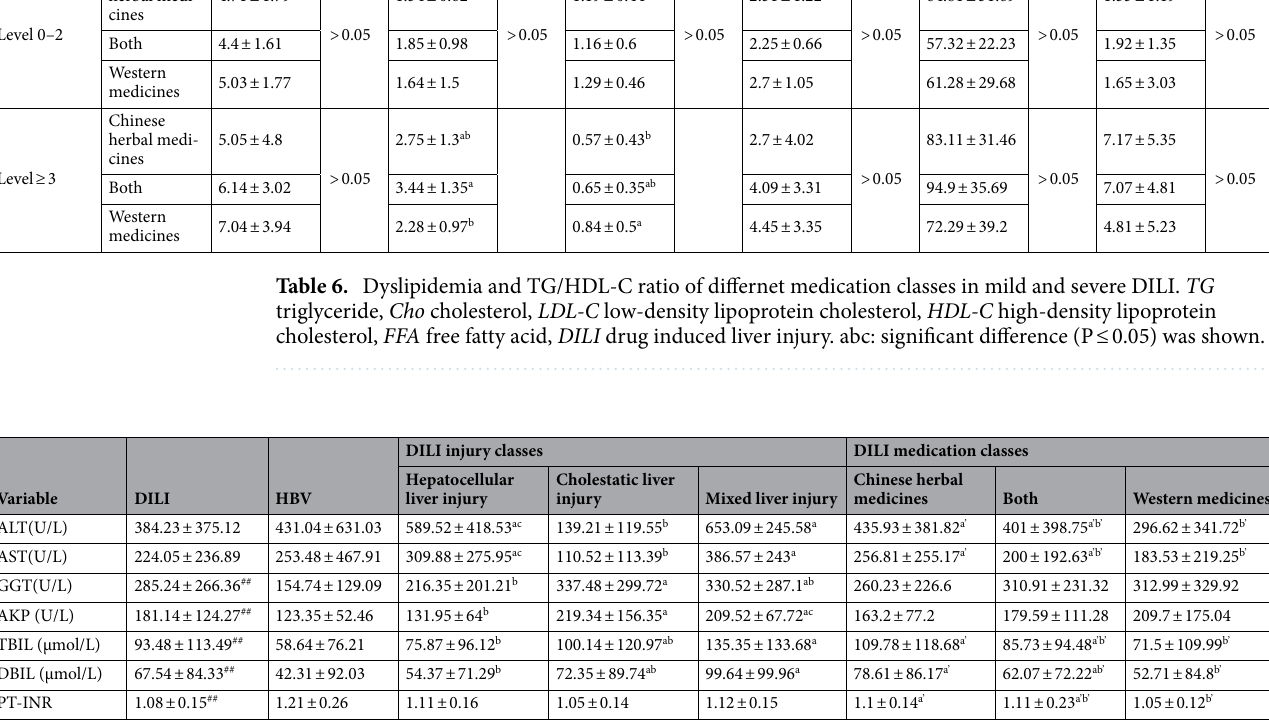
Table 7. Liver functions in DILI and acute hepatitis B group. ALT aminotransferase, AST Aspartate transaminase, GGT gamma-glutamyl transferase, AKP alkaline phosphatase, TBIL total bilirubin, DBIL direct bilirubin, PT-INR International normalized ratio of prothrombin time. # P ≤ 0.05; ## P ≤ 0.01. abc: significant difference (P ≤ 0.05) was shown in different DILI injury classes. a’b’c’: significant difference (P ≤ 0.05) was shown in different DILI medication